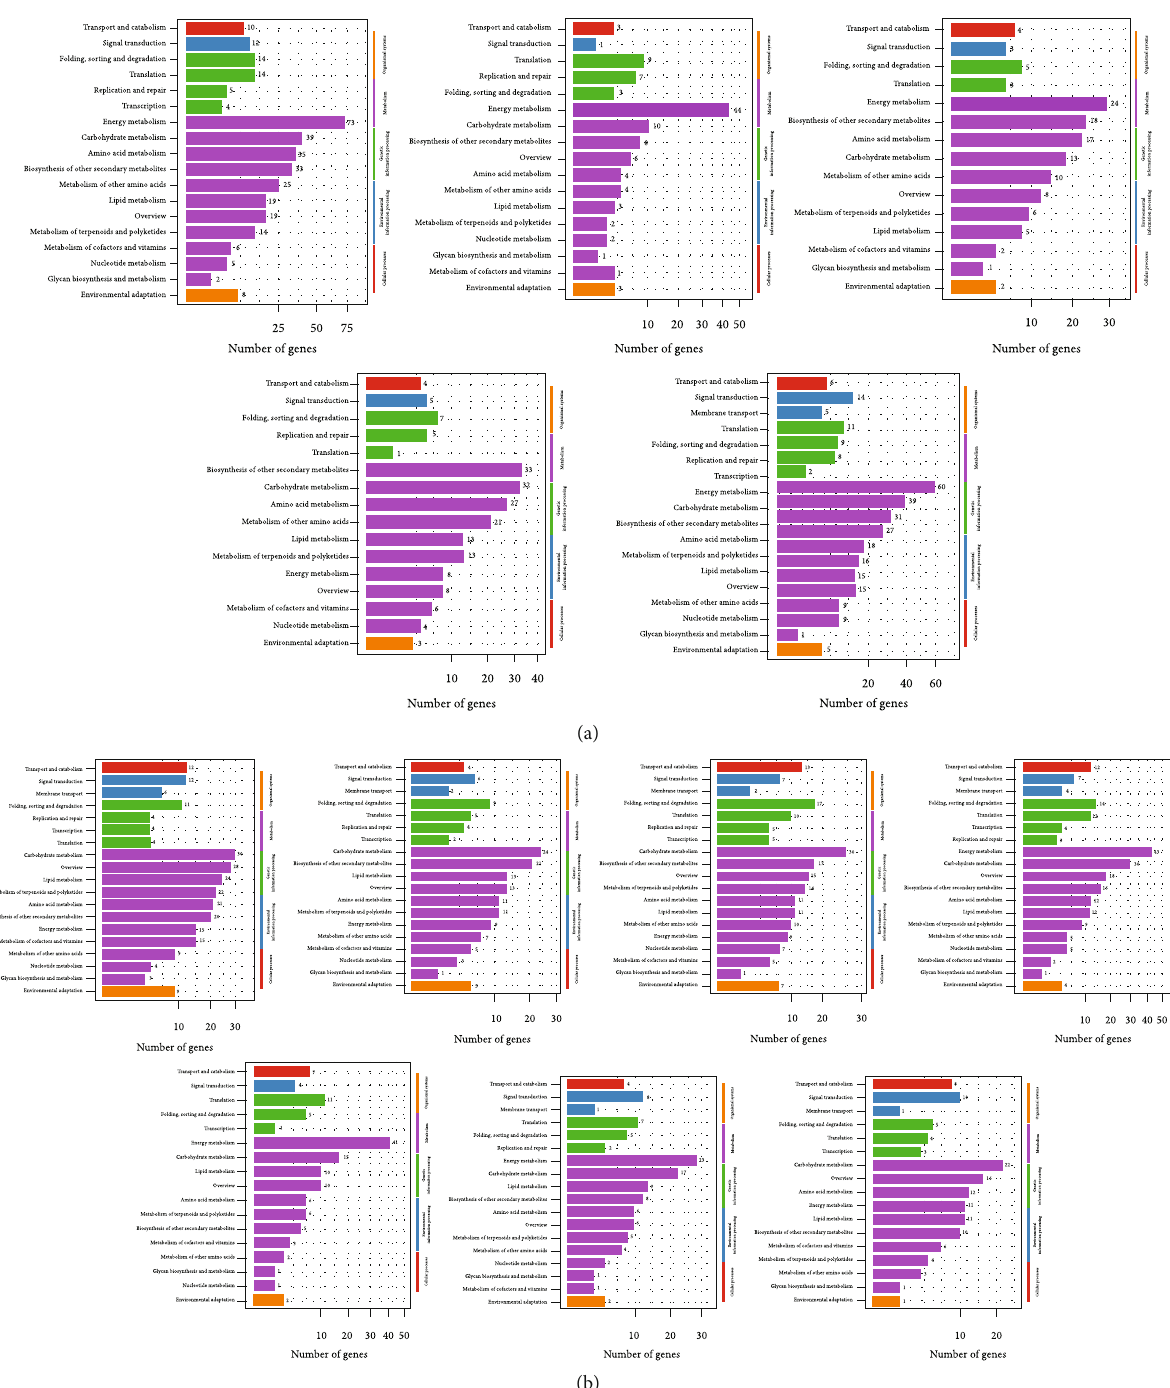
Figure 3: KEGG classi fi cation of di ff erentially expressed genes. (a) KEGG classi fi cation analysis of DEGs in XL106 (from left to right: XL106_ 1007 vs. XL106_0915, XL106_1007 vs. XL106_0922, XL106_1007 vs. XL106_0930, XL106_1007 vs. XL106_1014, and XL106_1007